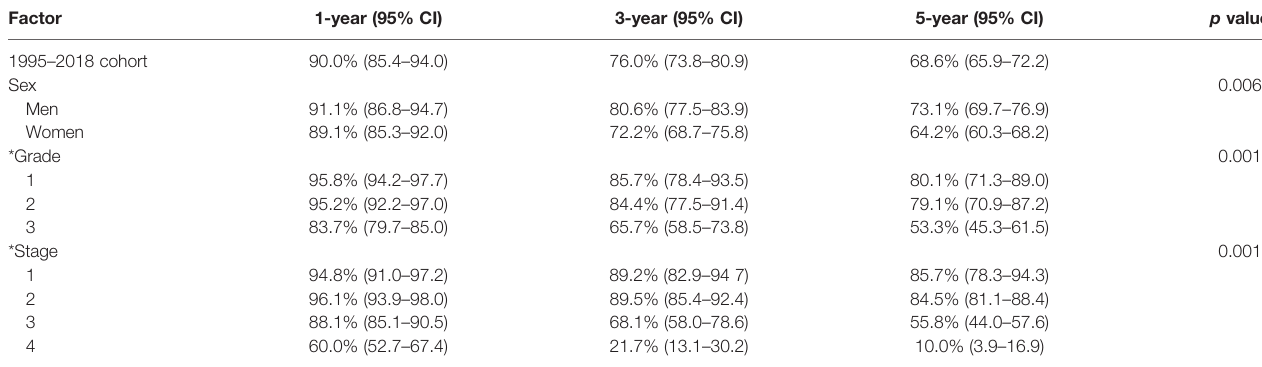
TABLE 3A | Overall survival by prognostic factors in 1995 – 2018.